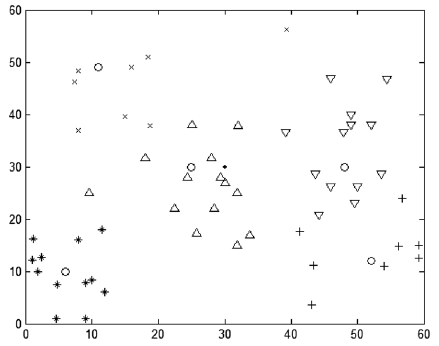
Figure 5. Division of configuration transfer points based on HQDRO.